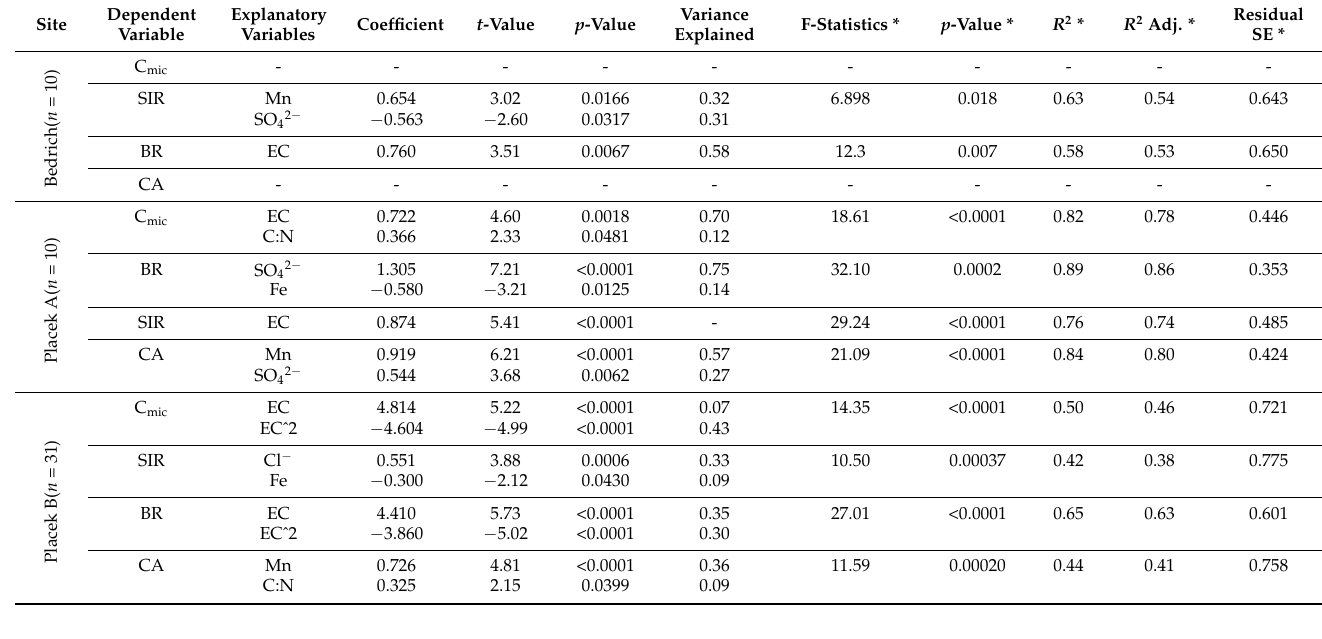
Table 2. Linear regression models of soil biological properties at the three study sites in 2020; separate statistics are provided for the prediction terms (explanatory variables), and for the whole model (indicated with *); C mic = microbial-biomass carbon; SIR = substrate-induced respiration; BR = basal respiration; CA = catalase activity; EC = electrical conductivity; for comparability of regression coefficients, the data were standardized prior to analysis.